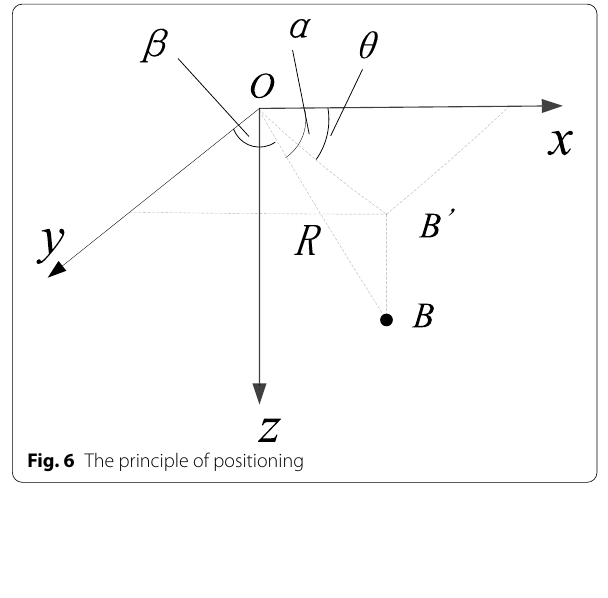
Fig. 6 The principle of